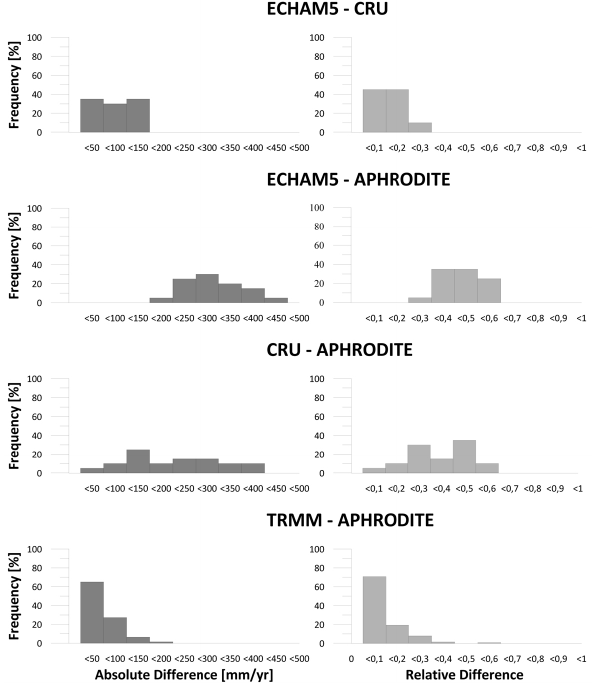
Fig. 6. Frequency distribution of the absolute and relative differ- ences in mean precipitation from ECHAM5 and CRU, ECHAM5 and APHRODITE and CRU and APHRODITE for 1981-2004 and TRMM and APHRODITE for